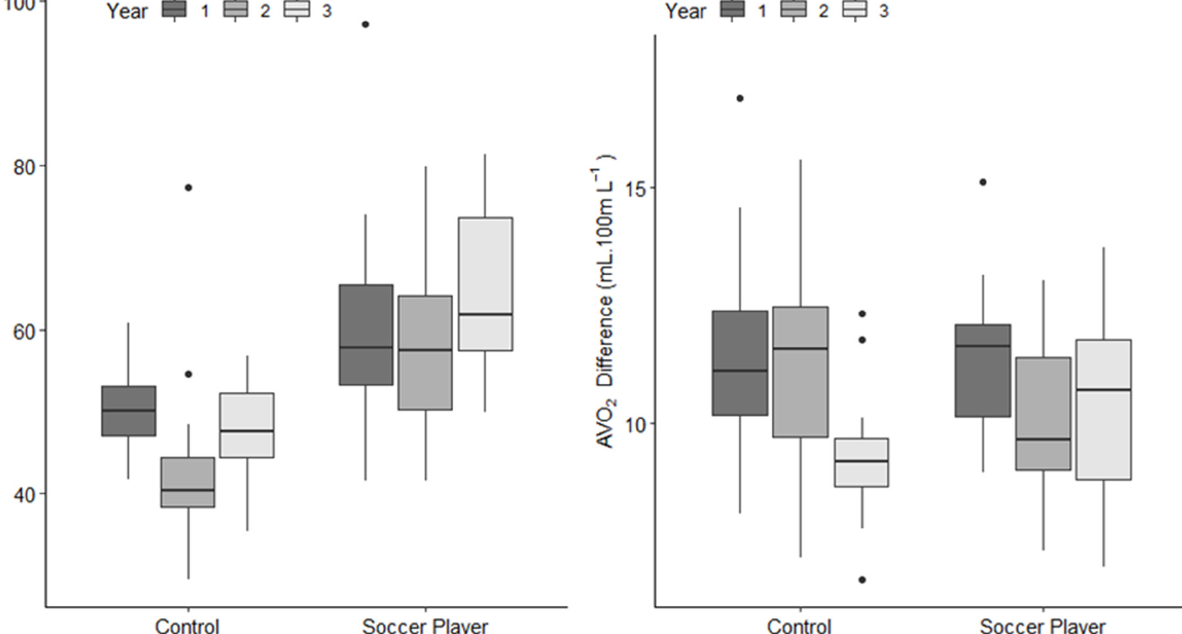
Figure 4. Changes in heart rate (HR), cardiac index (QIndex), stroke volume index (SVIndex), and arterial-venous oxygen difference (AVO 2 difference) at approximately 45% 𝑉(cid:4662) 𝑂 (cid:2870)(cid:3043)(cid:3032)(cid:3028)(cid:3038) in the control participants and soccer players over the course of the three-year observational study. All values are median and inter-quartile range. Unnithan et al. [1]. Reprinted with permission from Unnithan et al., [1], 2022, John Wiley and Sons.